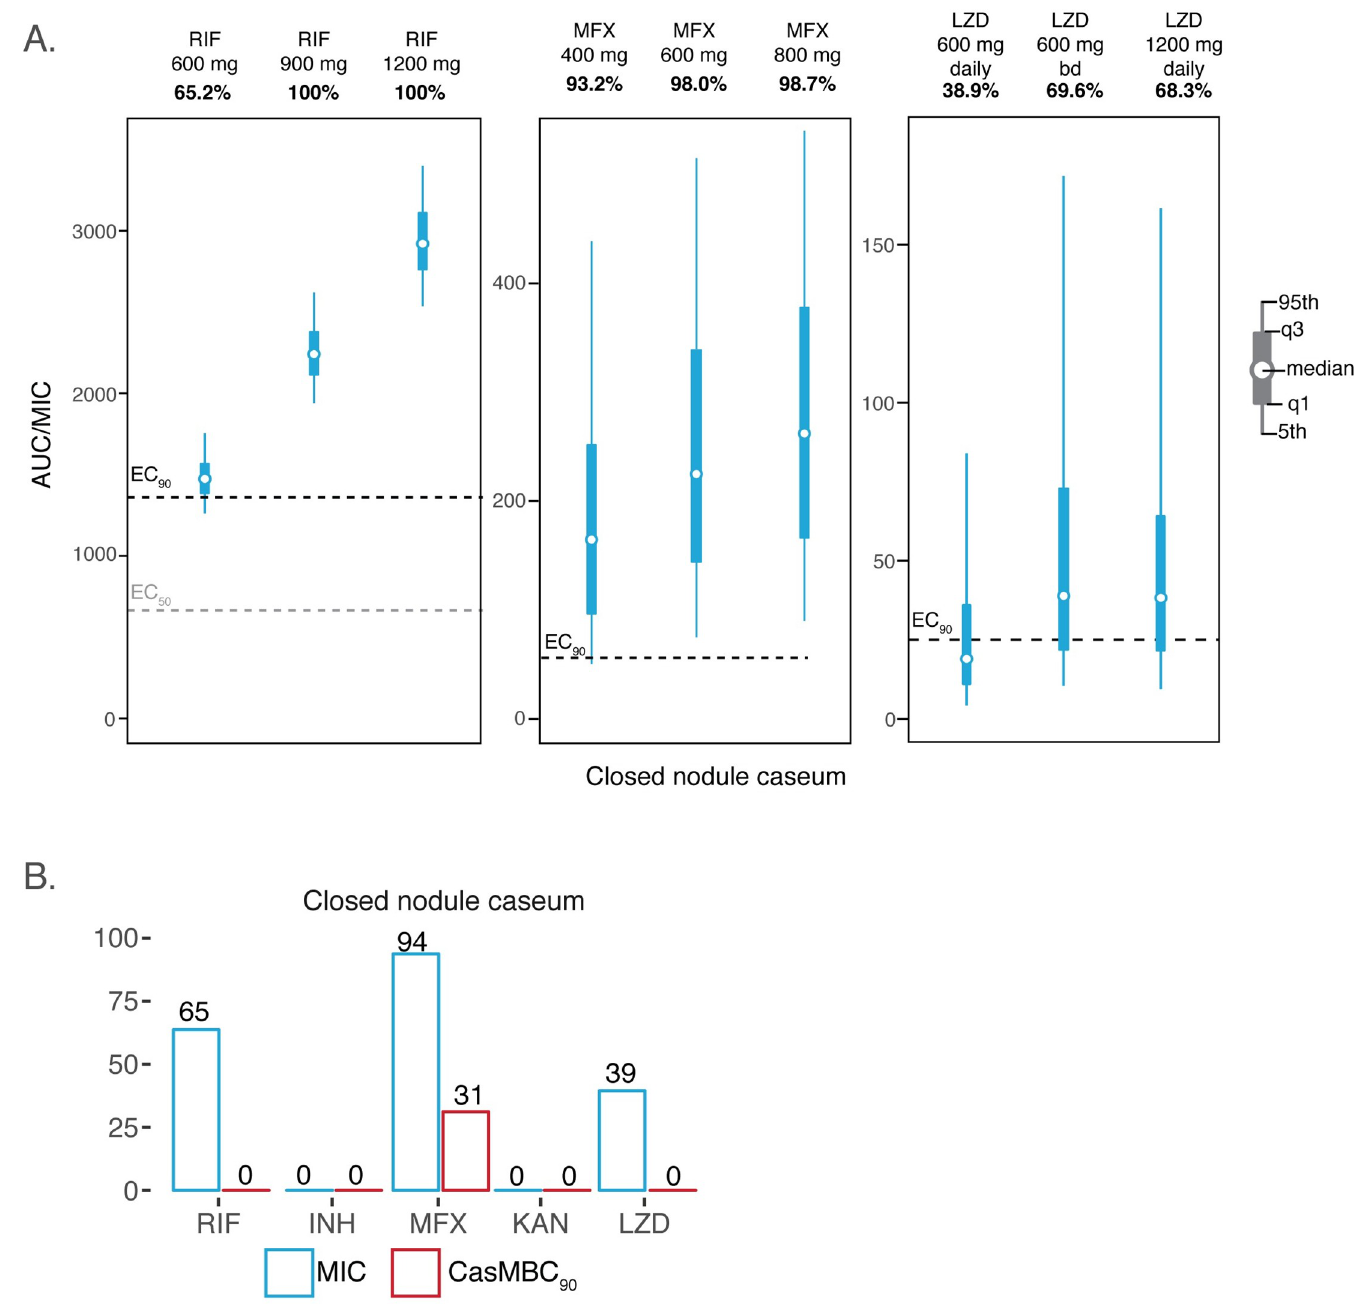
Fig 9. Predicted contribution of drugs by lesion type. A. RIF, MFX, and LZD simulations were performed at higher doses to observe their impact in hard-to-treat caseum from closed nodule. Their respective exposure distribution in 1,000 patients are shown in relation to their critical exposure value to reach EC 90 (black lines), and EC 50 (gray bars) if available. B. The percentage PK/PD efficacy target reached by a 1,000 simulated patient PK profiles as defined by their drug exposure versus drug MIC is shown in blue. Red boxes use CasMBC 90 instead of MIC in the same set of simulated patients to compare that efficacy is both lesion and drug specific. EC 90 , 90% maximal effective concentrations; LZD, linezolid; CasMBC 90 , caseum-specific minimum bactericidal concentration; MIC, minimum inhibitory concentration; MFX, moxifloxacin; PK/PD, pharmacokinetic/pharmacodynamic; RIF, rifampicin.